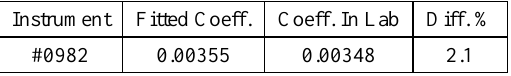
Table 1. Comparison of calibration results. The difference between two results is about